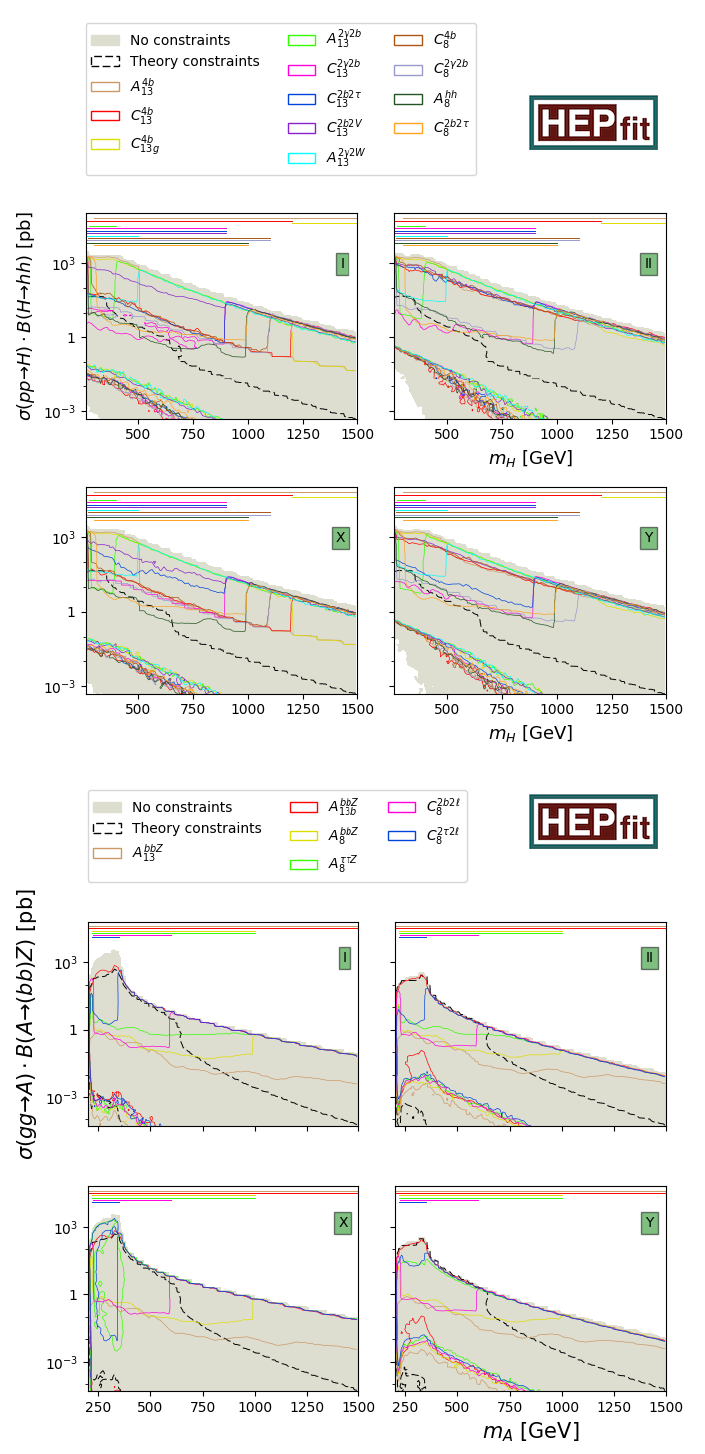
Figure 11 . 95% contours of the single searches for H ! hh (top) and A ! hZ (bottom) in the (cid:27) (cid:1) B vs. m planes for the four 2HDM types. For details, see text. H=A